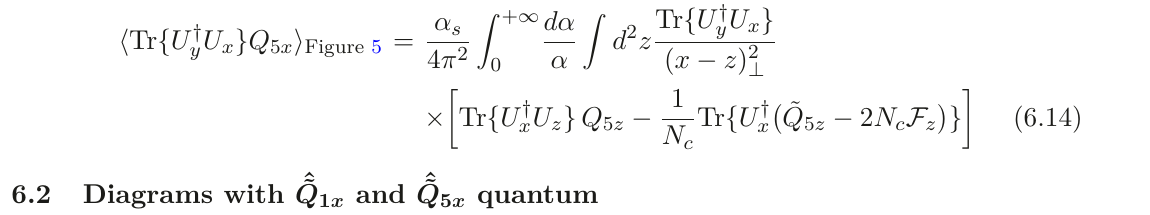
Figure 6 . Diagrams with ˜ Q